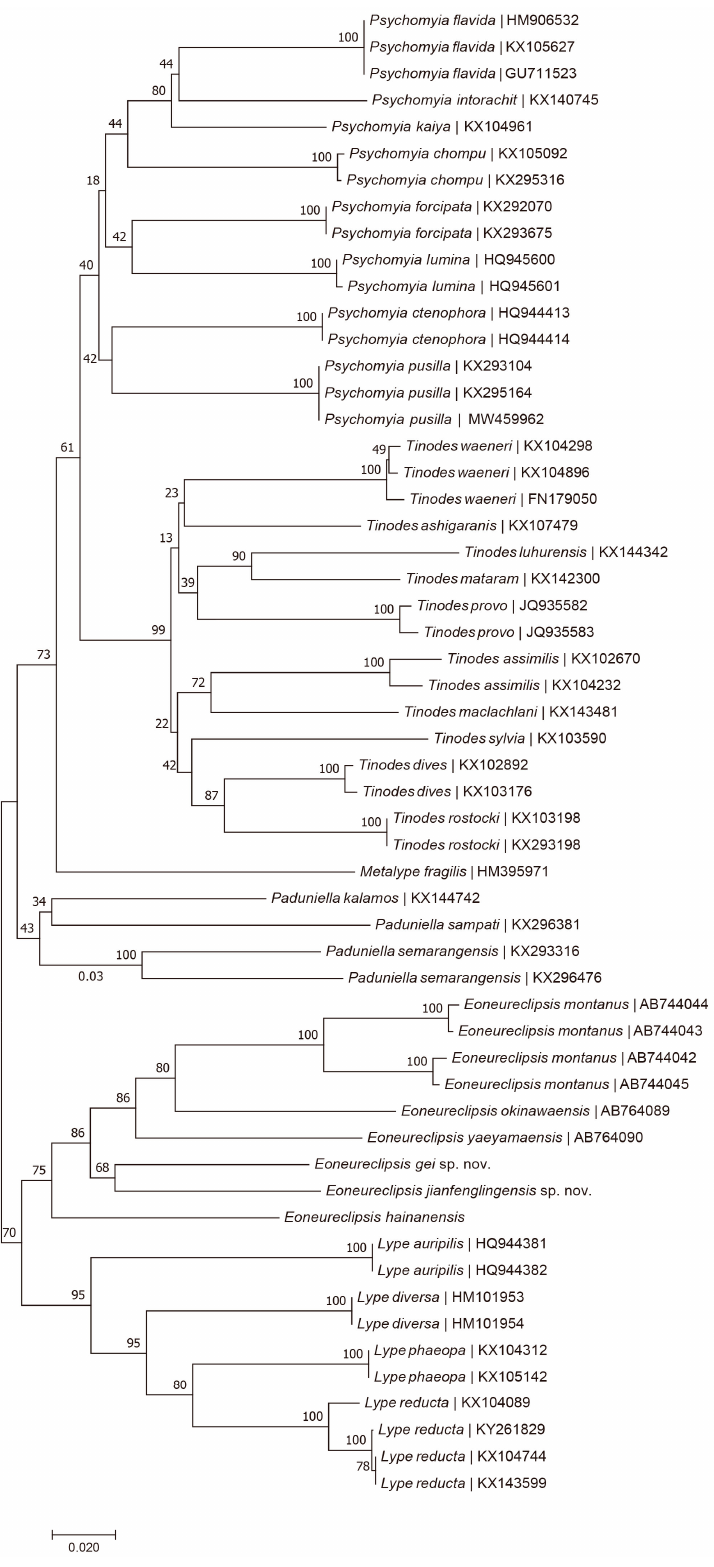
Figure 8. Neighbor-joining cladogram based on the 658 bp long mt COI sequence of six Eoneureclipsis species. Numbers on branches represent the bootstrap values based on 1000 replicates; scale bar indicates Kimura's 2-parameter genetic distance of 0.02.